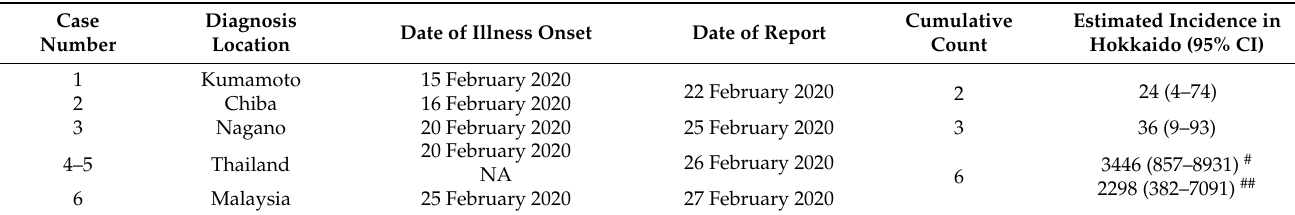
Table 1. Exportation events and estimated incidence in Hokkaido by date of report.